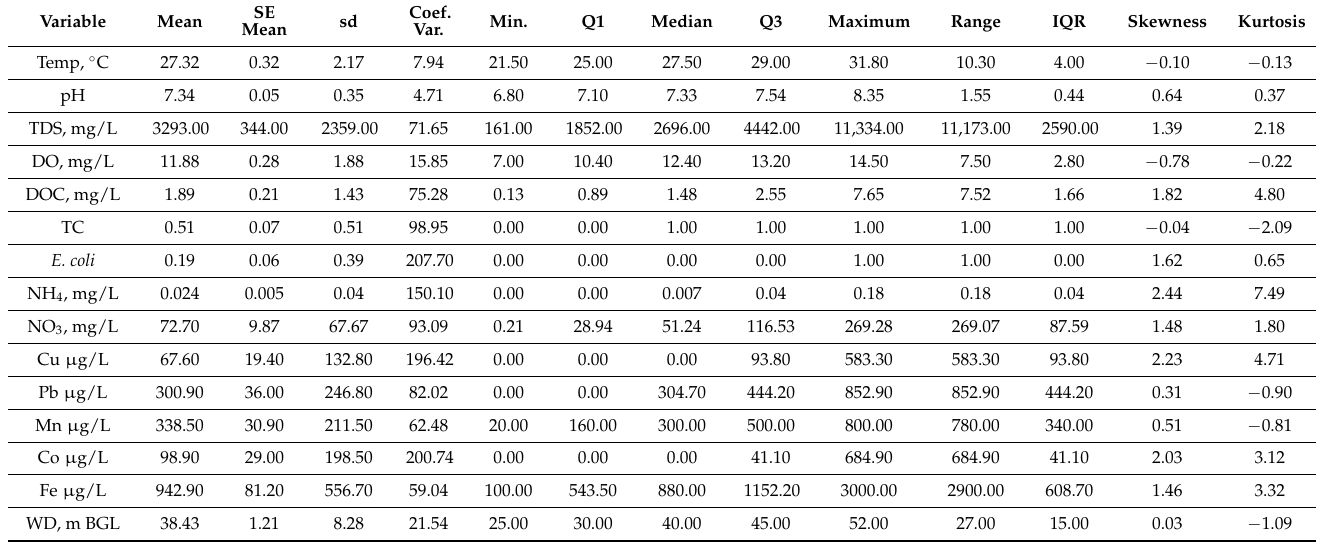
Table 1. Descriptive statistics summary of the concerned measured parameters in the groundwater